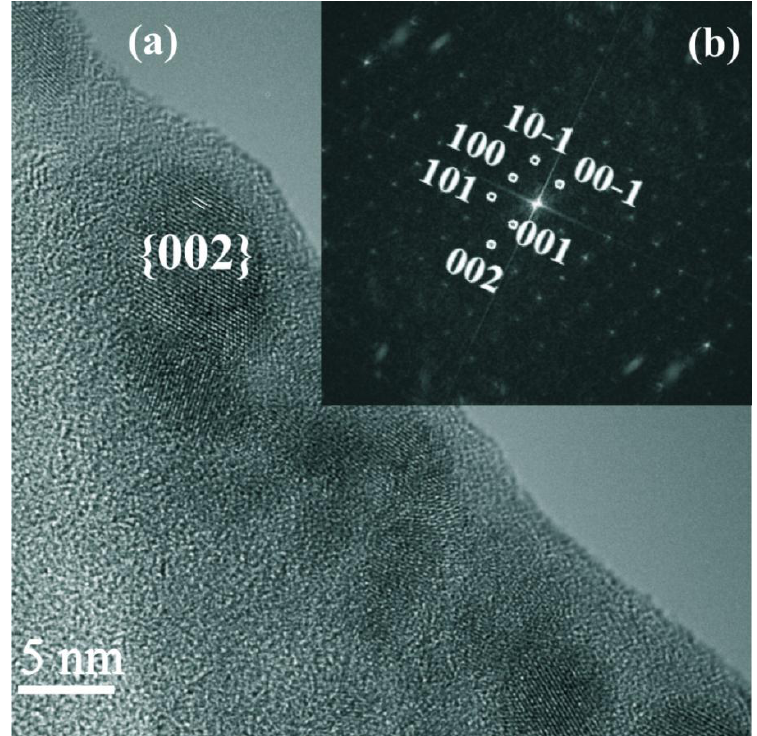
Figure 5. ( a ) Cross section HRTEM image of an area of MBE MnGe layer deposited at 350 °C and ( b ) the associated FFT pattern showing the presence of Mn direction